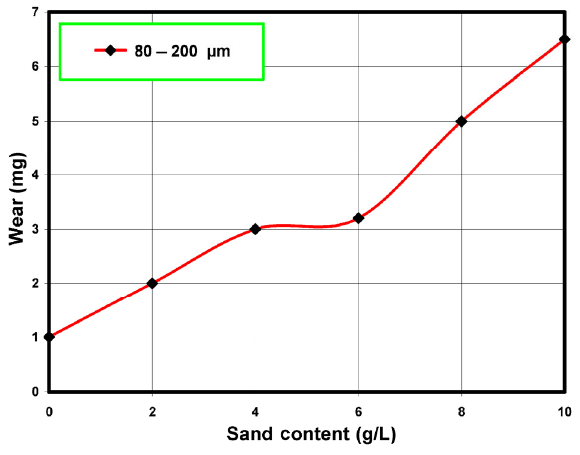
Fig. 12 Effect of sand contamination in lubricant on wear for sand particles of size 80–200 µm.